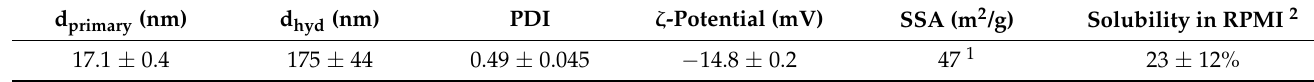
Table 1. Summary of the nanoparticle characterization.